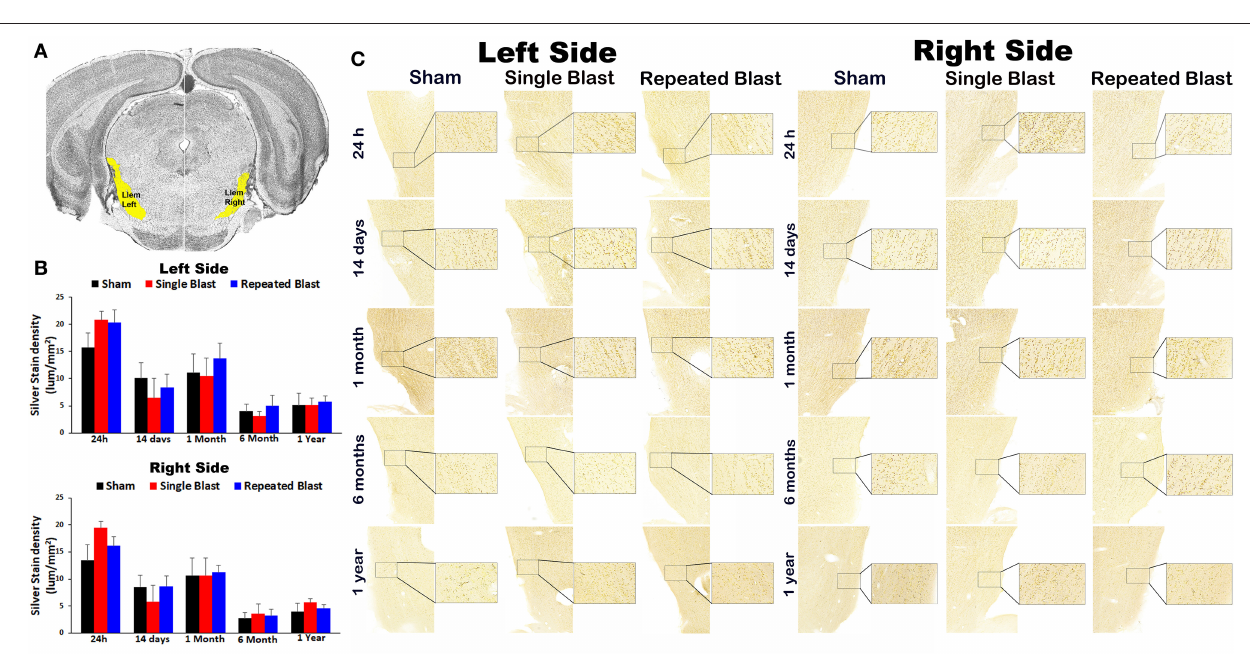
FIGURE 3 | Silver staining in the left and right lateral lemniscus. (A) Lateral lemniscus (Llem) region selected using the rat brain atlas for analysis. (B) Graphics showing densitometry analysis from the left and right silver-stained Llem regions at different intervals post-blast exposures. (C) Representative silver-stained images from the left and right Llem regions at different intervals after single and tightly coupled repeated blasts. Portions of sections inside rectangles are shown at higher magnification on the right. Values are expressed as mean ± SEM. Density values of single and repeated blast-exposed groups were compared to the respective sham controls ( p > 0.05, ANOVA; normal distribution; n =